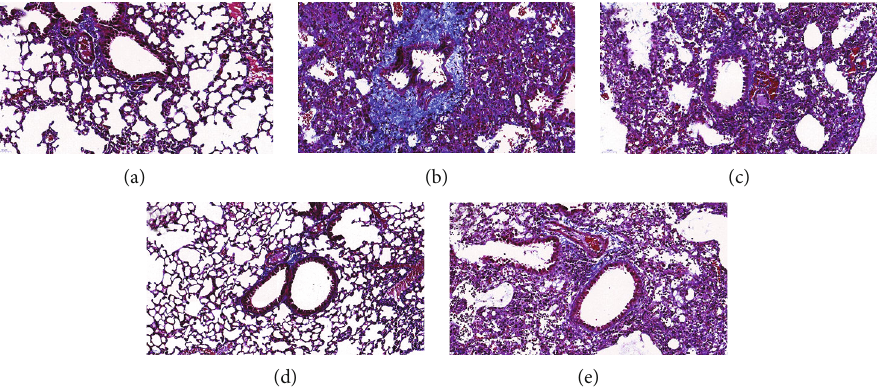
Figure 4: The e ff ect of YPG on bronchial asthma in rats. Sections were stained with Masson ’ s trichrome. Magni fi cation, × 400; scale bars,